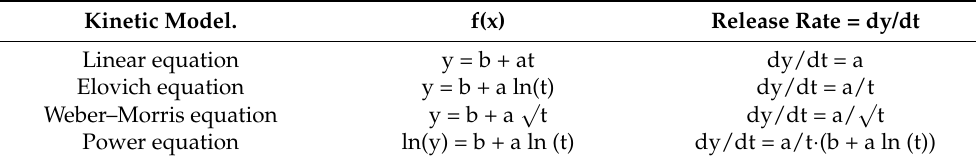
Table 2. Modelling the released concentrations from accumulated data.